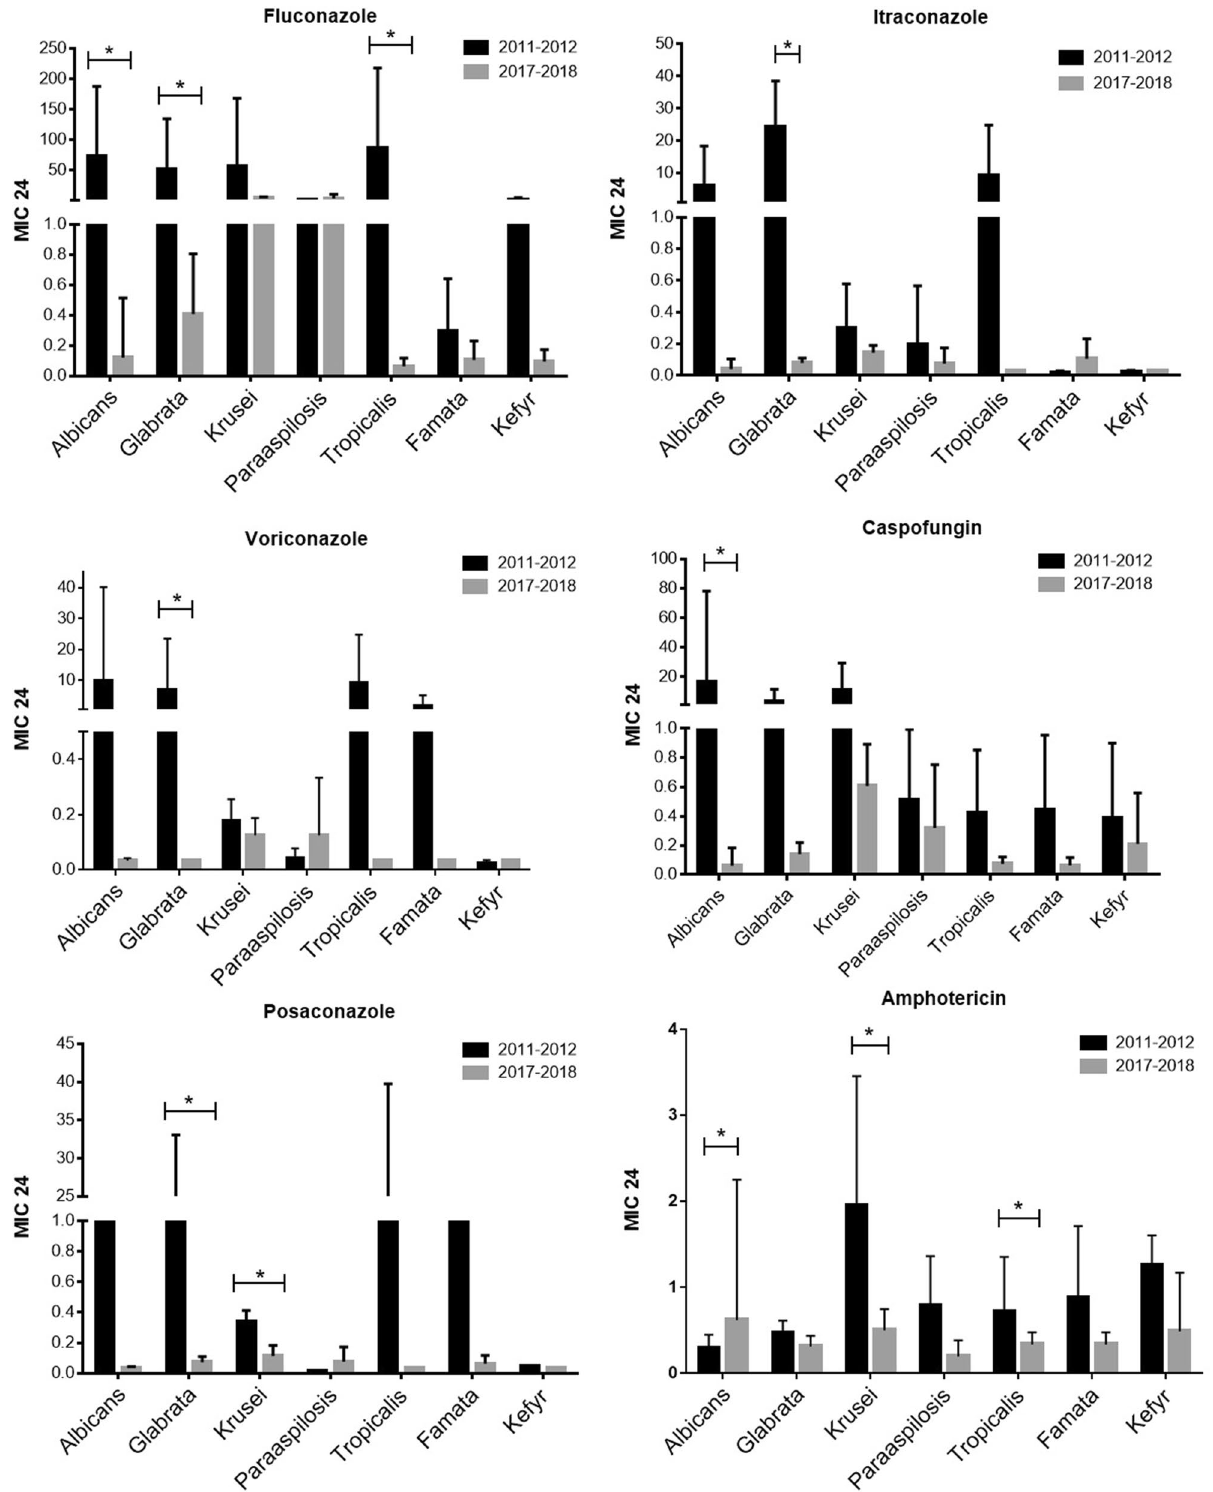
Figure 4. The mean MIC value (24-h) of C. albicans , C. glabrata , C. krusei , C. parapsilosis , C. tropicalis , C. famata , and C. kefyr for fluconazole, itraconazole, voriconazole, caspofungin, posaconazole, and amphotericin B, during the two study periods. Error bars represent standard deviations. *P ≤ 0.05 by the two-way ANOVA